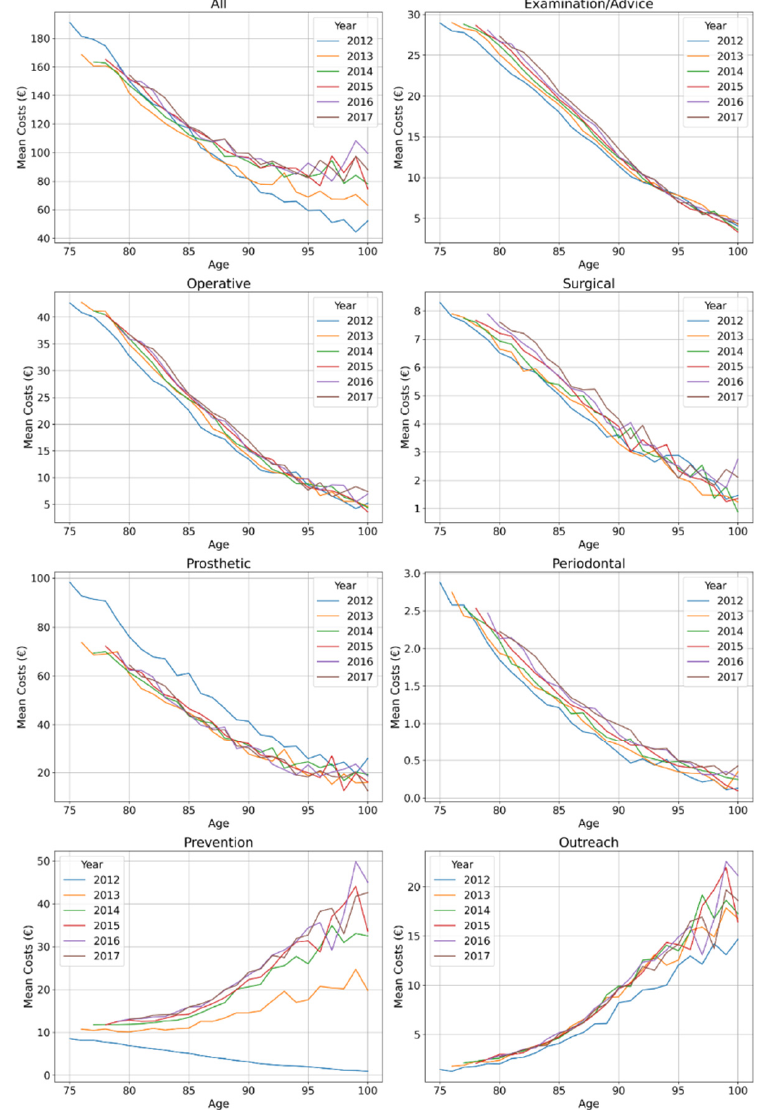
Figure 1. Mean costs (in euro 2012) of dental services provided to the very old in Northeast Germany. Total costs as well as costs for examination/advice, operative, surgical, prosthetic, periodontal, preventive and outreach services are shown. Individuals available in 2012 of all ages from 75 years upwards (blue line) were followed over 6 years until 2017 (brown line), i.e., the 75-year-olds in 2012 are the 76-year-olds in 2013 etc. (which is why the lines start further to the right with longer